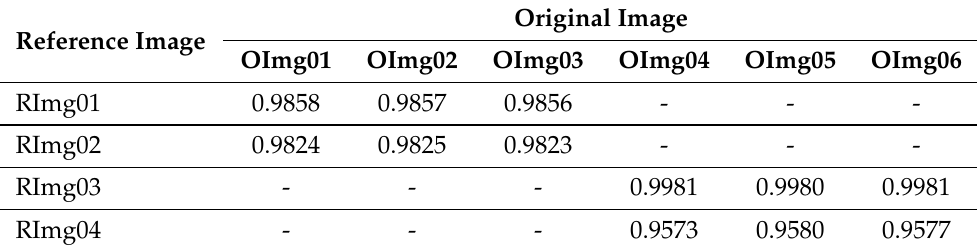
Table 2. Outcomes of SSIM test for encrypted